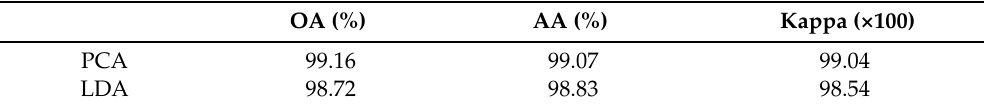
Table 2. Classification results using PCA and LDA on the IP